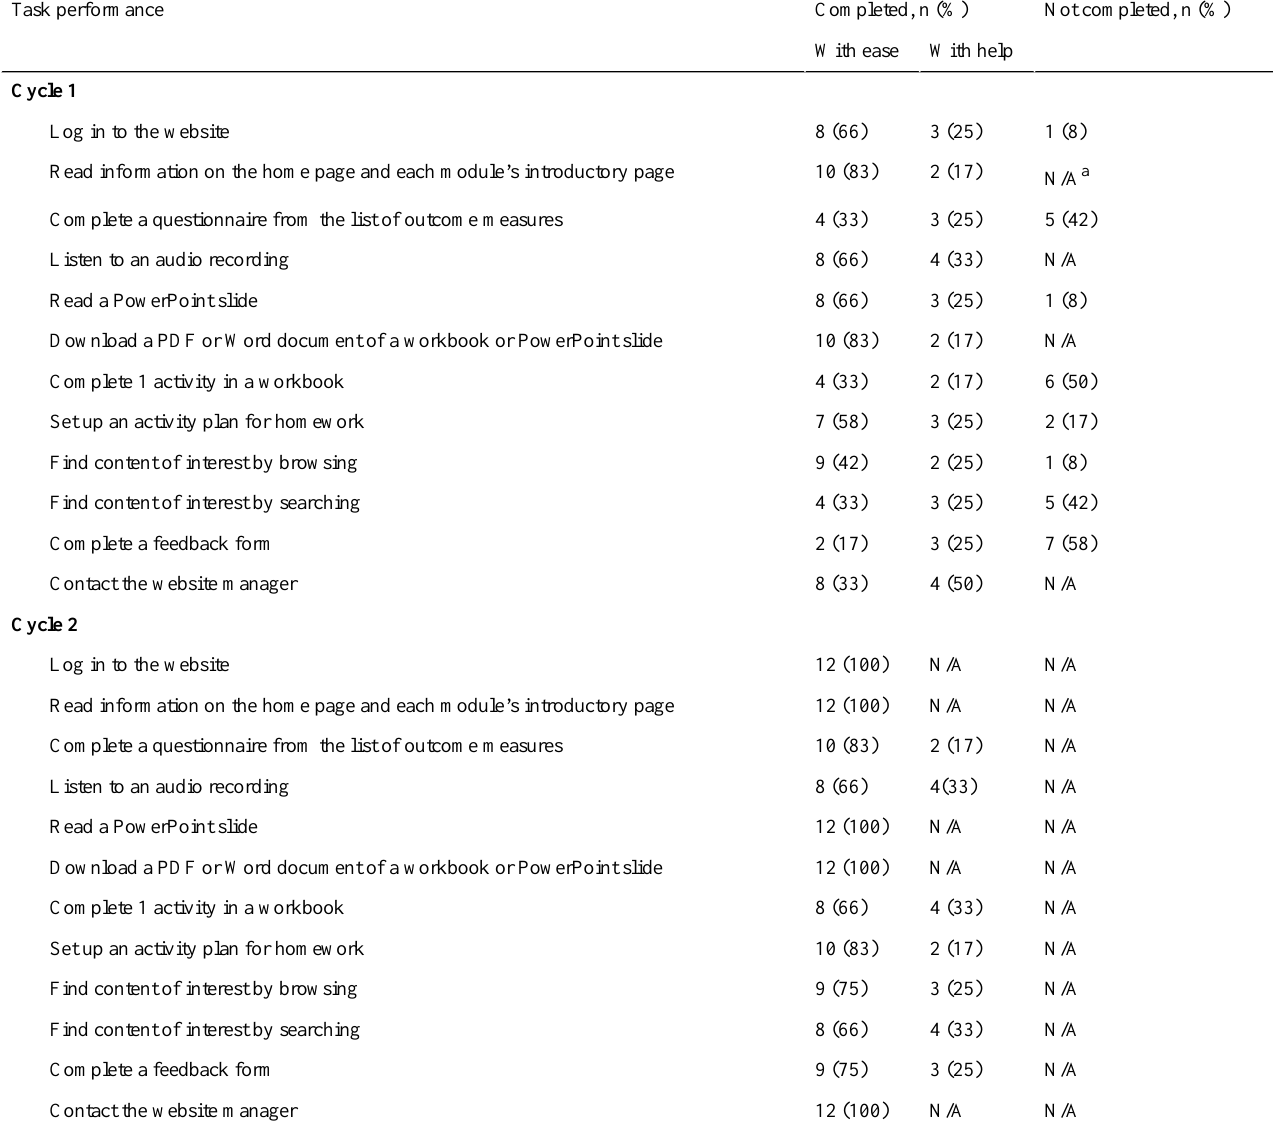
Table 3. Task performance findings during usability testing